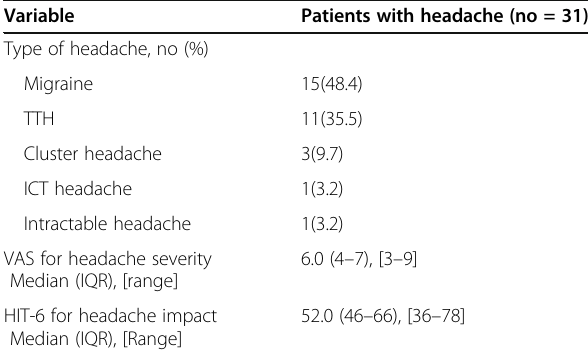
Table 1 Headache characteristics of SLE patients